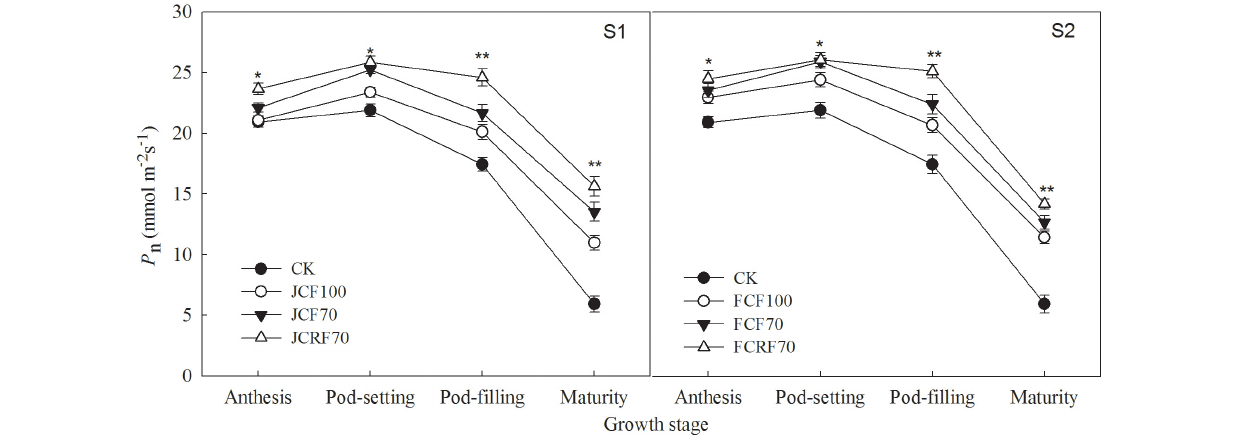
( Figure 6 ). The effects of N treatment on total N uptake and translocation in peanut were very significant ( P < 0.01), but there were no significant year × stage × N treatment interaction effects on total N uptake and distribution at the maturity stage ( Table 5 ). The total N uptake under JCF70 and JCRF70 was higher than those under JCF100 by 14.5